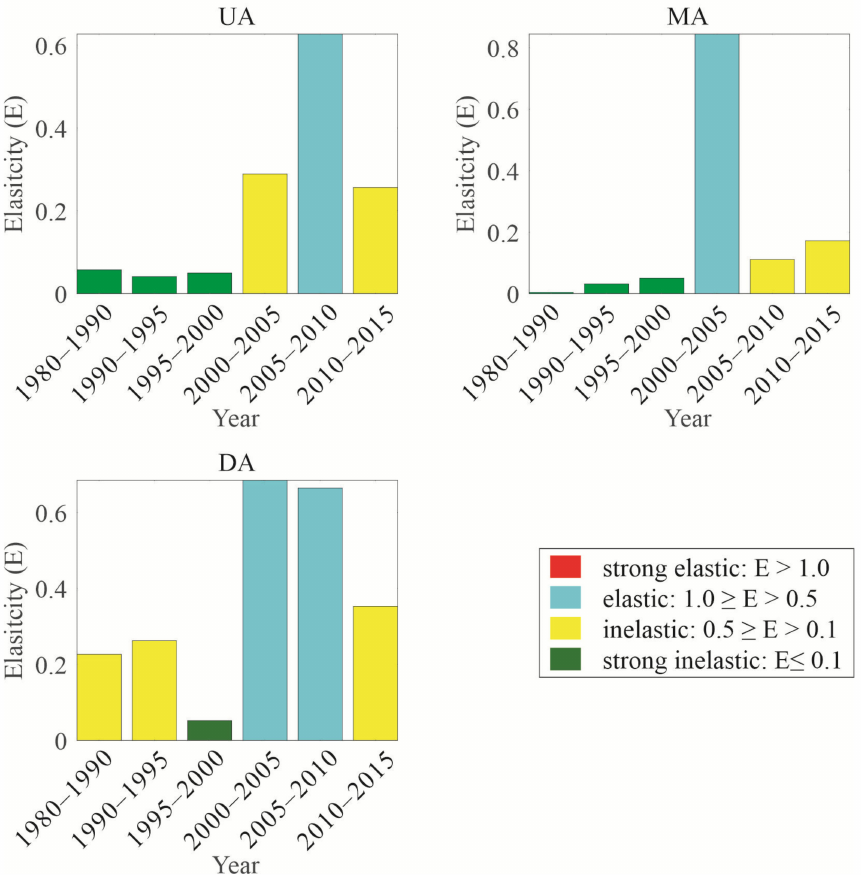
Figure 5. Elasticity of ESV changes in response to LULC change of YRB, SA, UA, MA, and DA from 1980 to